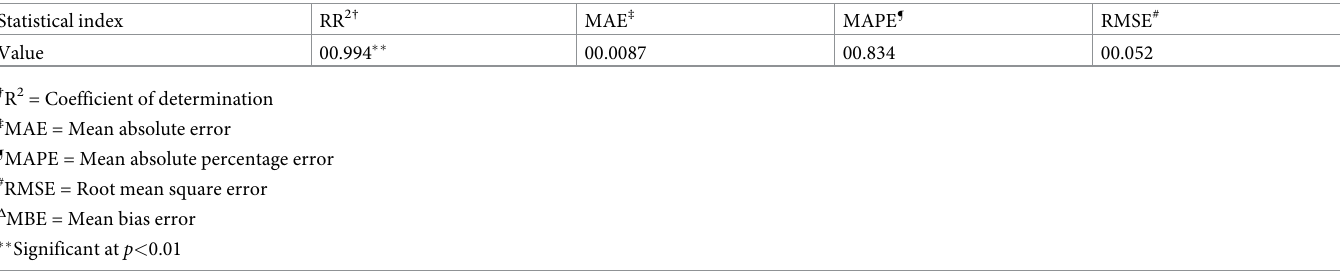
Table 9. Statistical criteria for evaluating the performance of artificial neural networks (ANNs) for predicting wheat grain yield under different treatments based on grain and straw N uptake, grain and straw K uptake, total N and total K uptake, SPAD value, green seeker value, and reciprocal internal use efficiency of N (RIUE N ) and K (RIUE K ).